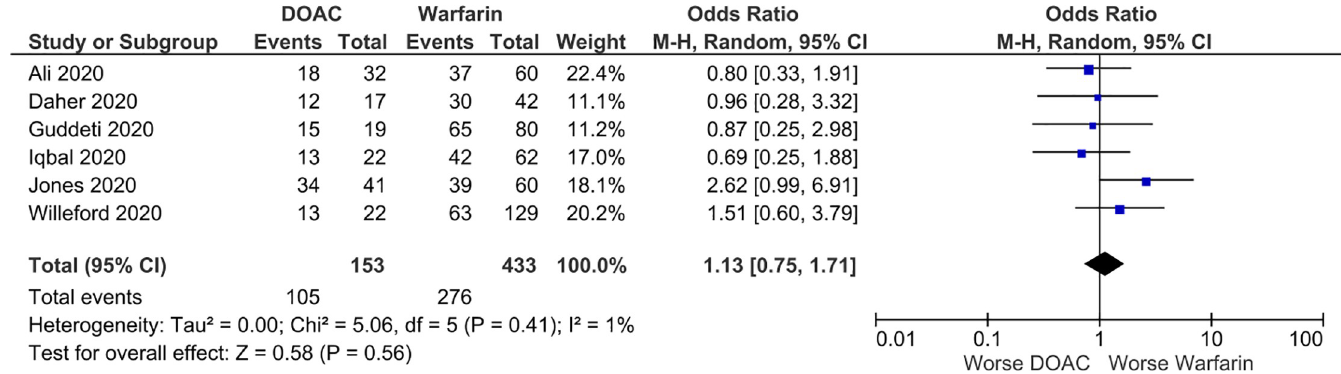
Fig 3. Forest plot of left ventricular thrombus resolution rate in patients with left ventricular thrombus receiving DOACs versus VKA.